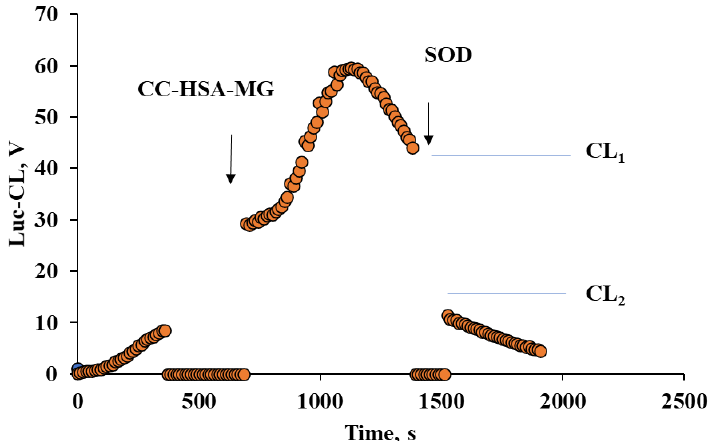
Figure 6. Kinetics of Luc-CL of neutrophils stimulated by vaterite with adsorbed HSA-MG (5 mg/g CC) before and after 120 Un/mL SOD addition. Microparticle concentration: 1 mg/mL; neutrophil concentration: 0.5 × 10 6 cells/mL .